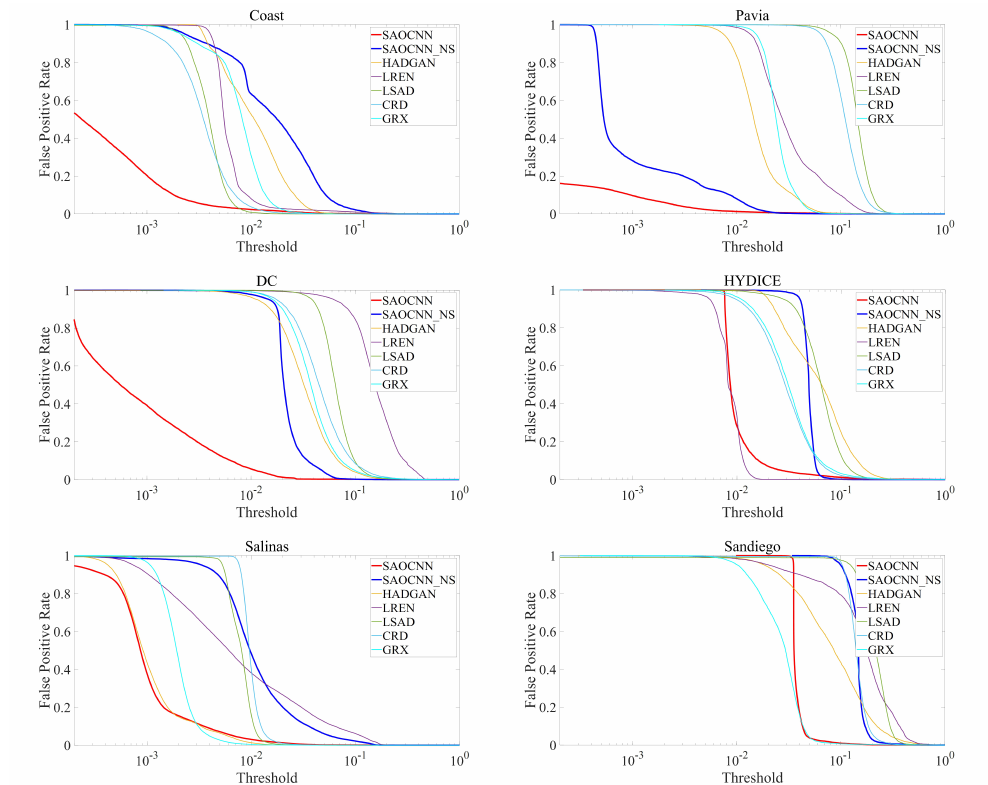
Figure 8. ROC of ( P f , τ ) for SAOCNN, SAOCNN_NS, HADGAN, LREN, LSAD, CRD, and